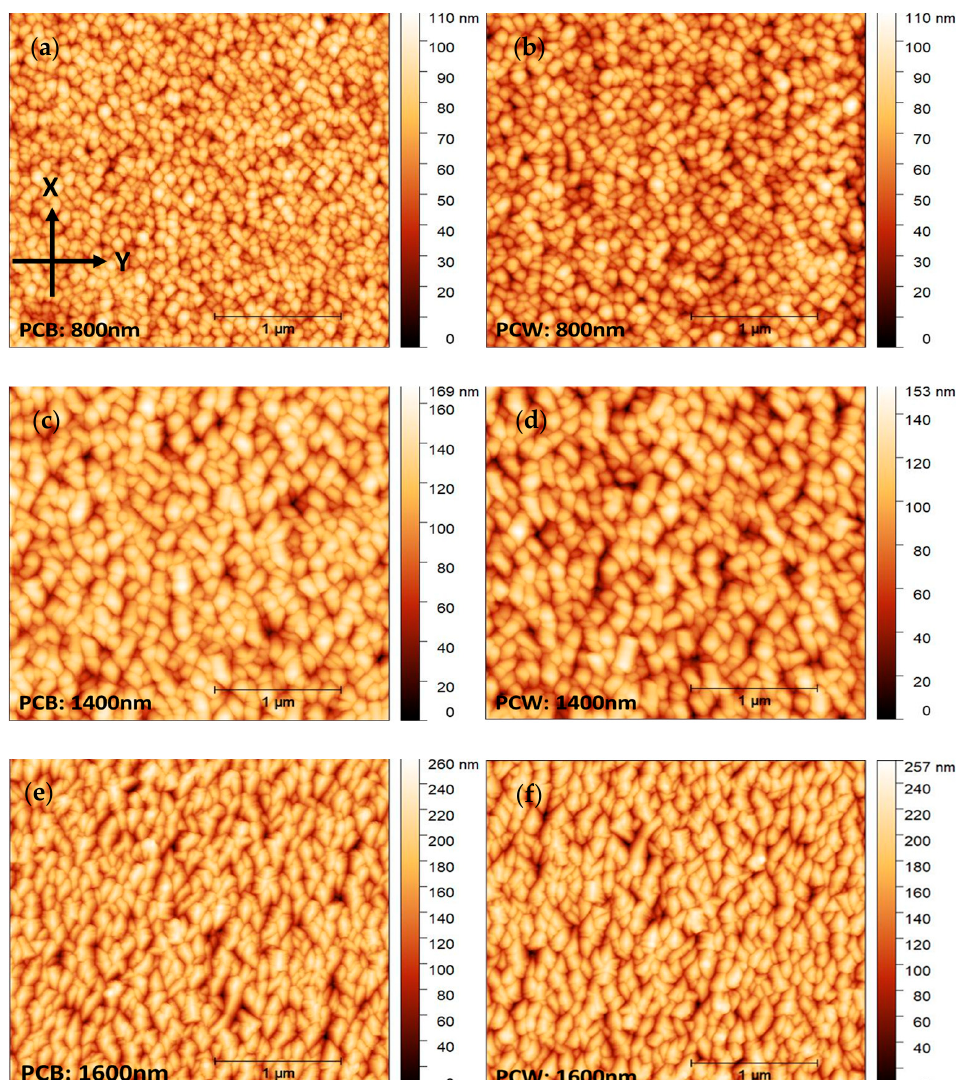
Figure 3. Topographical AFM images of coatings deposited on polymeric substrates: ( a ) PCB (800 nm), ( b ) PCW (800 nm), ( c ) PCB (1400 nm), ( d ) PCW (1400 nm), ( e ) PCB (1600 nm, in an area without hillocks), and ( f ) PCW (1600 nm, in an area without hillocks). The images shown in Figure 4a represent on the Y-axis the tangential component of the substrates’ direction of rotation.